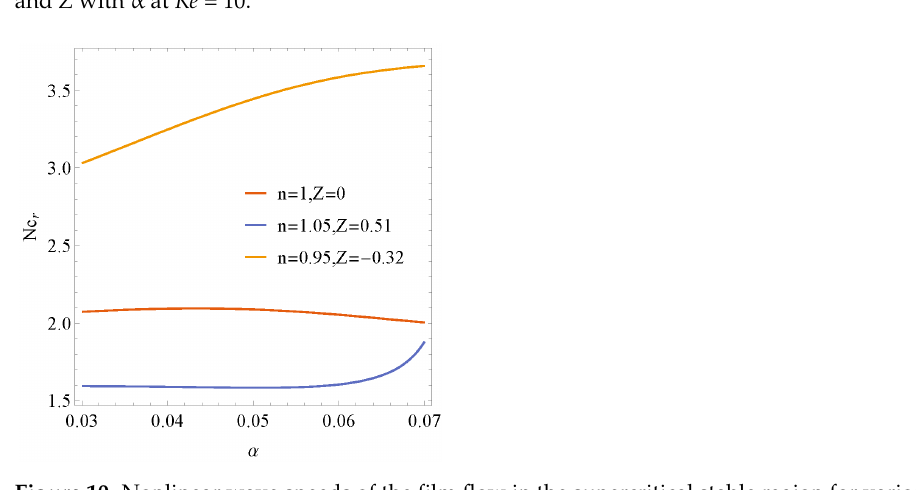
Figure 10. Nonlinear wave speeds of the film flow in the supercritical stable region for various n and Z with α at Re = 10.